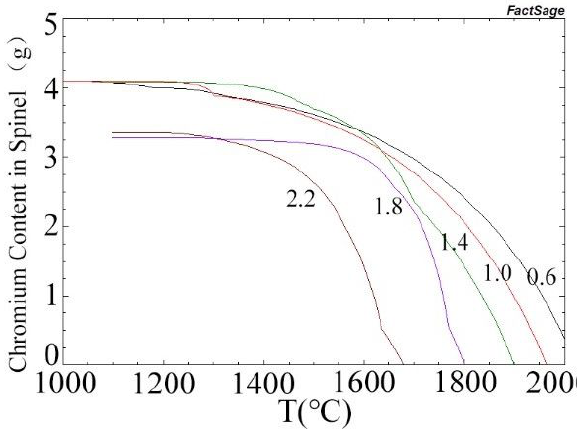
Figure 2: Effect of basicity on chromium content in spinel solid solution.